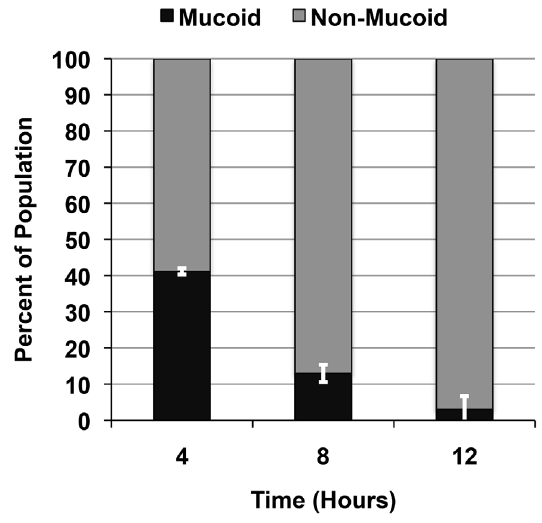
Figure 6. Fitness of MN8m versus JB12. The competitive fitness of MN8m in co-culture with PNAG-negative, non-mucoid JB12 was determined by combining the two strains and enumerating each strain over time. Bars represent the value of each phenotype as percent of total population, determined by enumerating colonies on CRA. Values represent the mean of triplicate